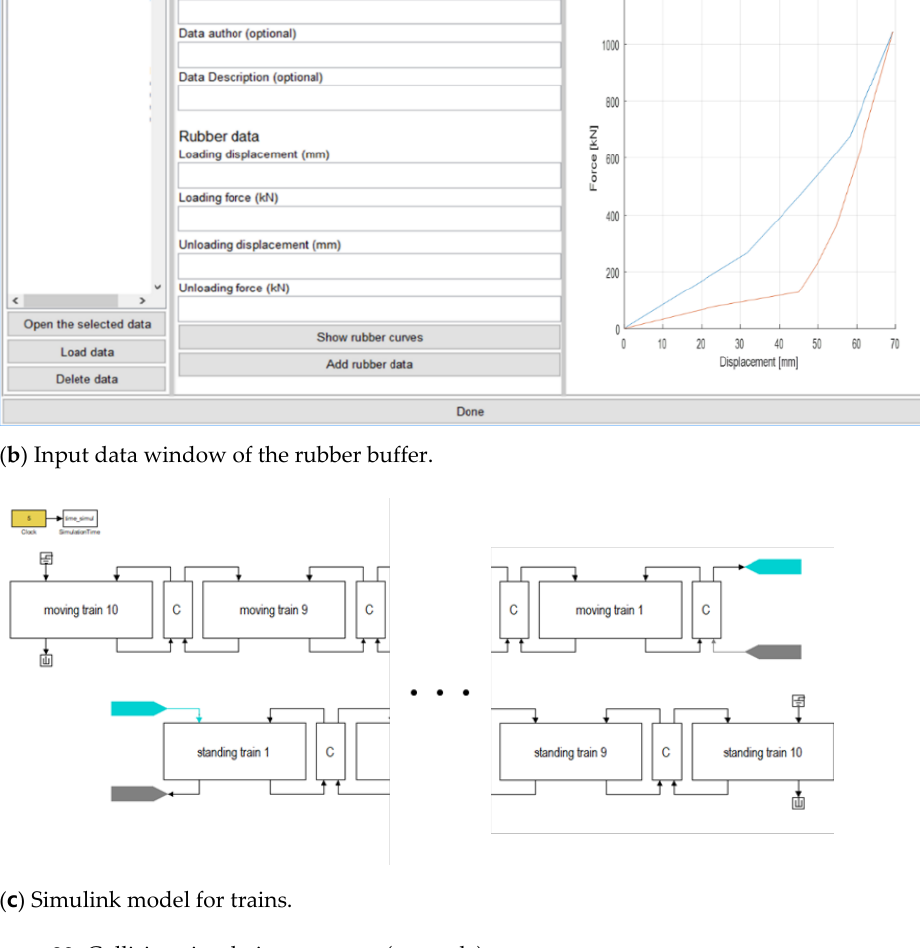
Figure 20. Collision simulation program (example).